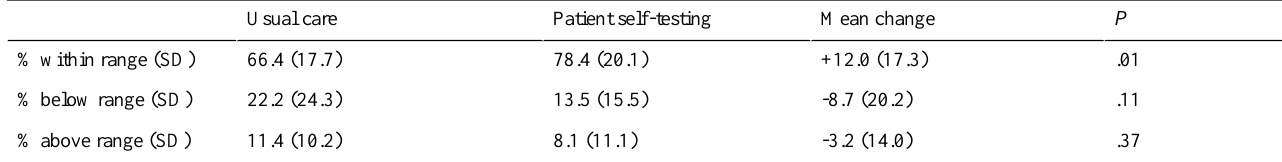
Table 2. Percentage of time in target